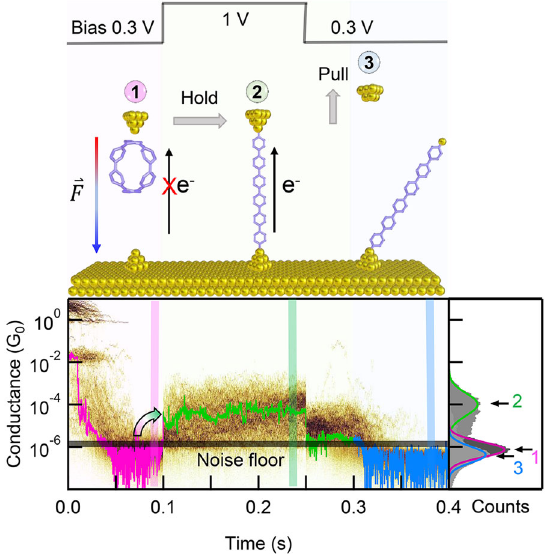
Fig. 4 | Modi fi ed STM-BJ measurements for [6]CPP. The 2D conductance-time histogram is compiled from selected traces that show a switch from noise fl oor to characteristicconductanceofmoleculeunderthehighbiasduringtheholdperiod. The conductance pro fi les are determined from the three regions in the 2D